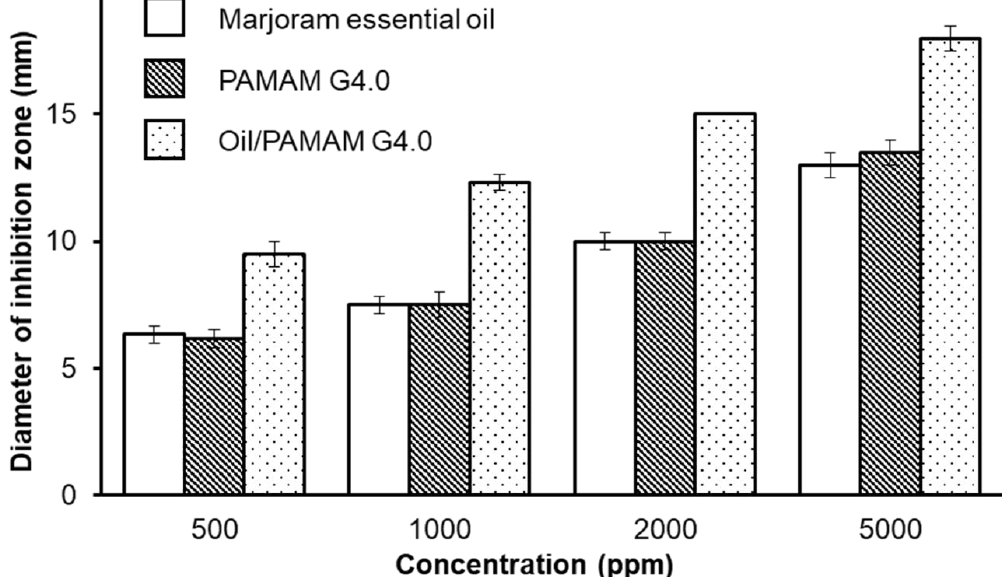
Figure 7. The graph concluding average inhibition zone (d. mm) against Phytophthora infestants of marjoram essential oil, PAMAM G4.0 and oil/PAMAM G4.0 based on different concentrations: 500, 1000, 2000 and 5000 ppm.